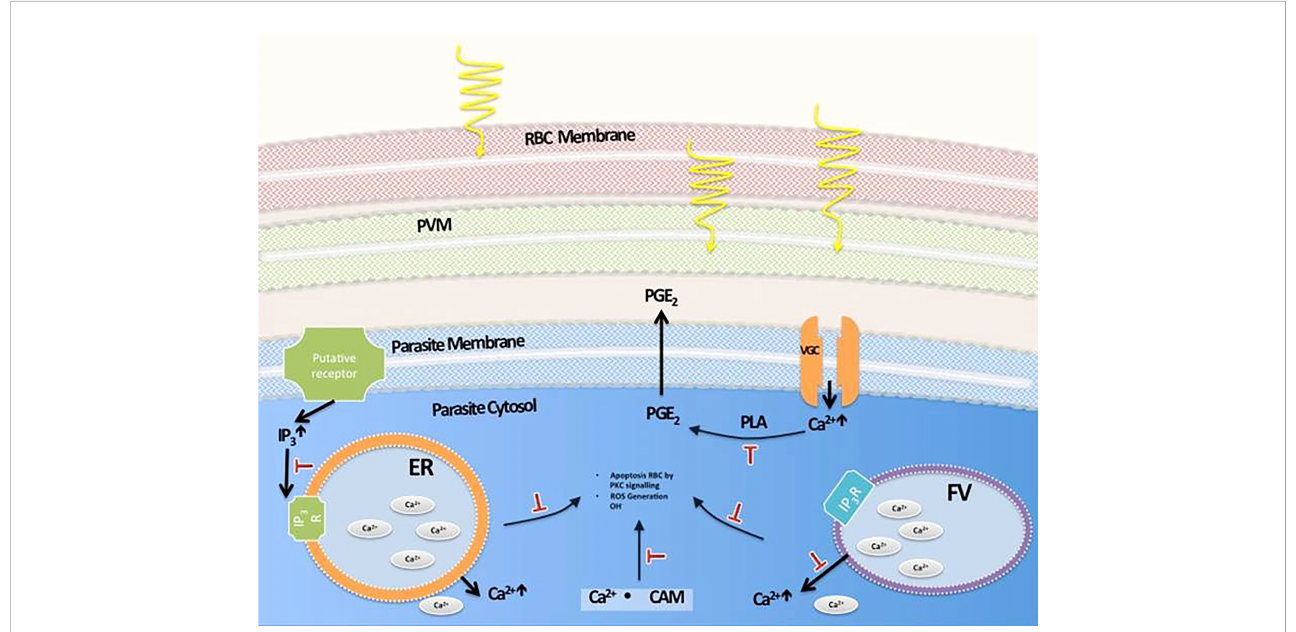
FIGURE 10 Proposed pathways involved in MW-induced death of malaria parasites. Movements of Ca 2+ from this ion storages of the parasite take place after MW exposure. Their inhibition with target molecules can partially or totally prevent their death by irradiation. (PVM: Parasitophorous vacuole membrane, ER: Endoplasmic reticulum, FV: Food vacuole, PGE2: Prostaglandin E2, PLA: Phospholipase A, IP3: Inositol Trisphosphate, CAM: